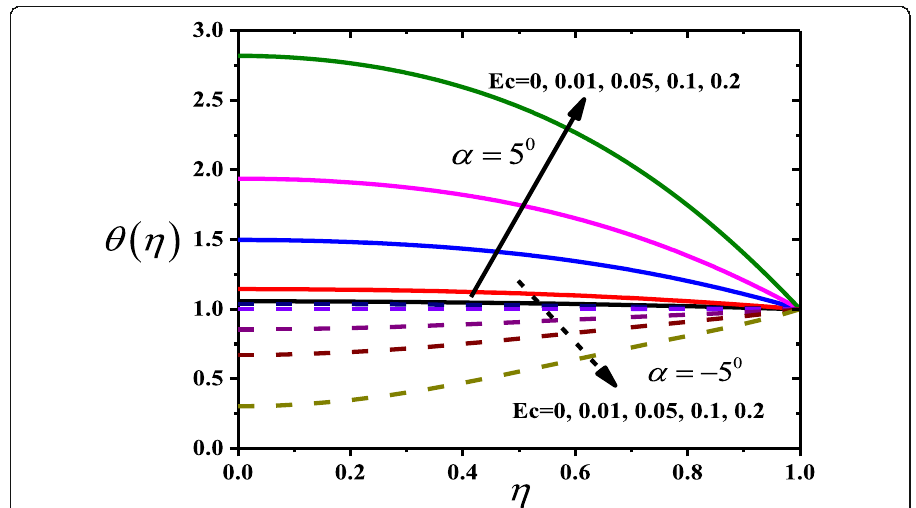
Fig. 10 Temperature vs. Ec in stretching divergent and shrinking convergent channels